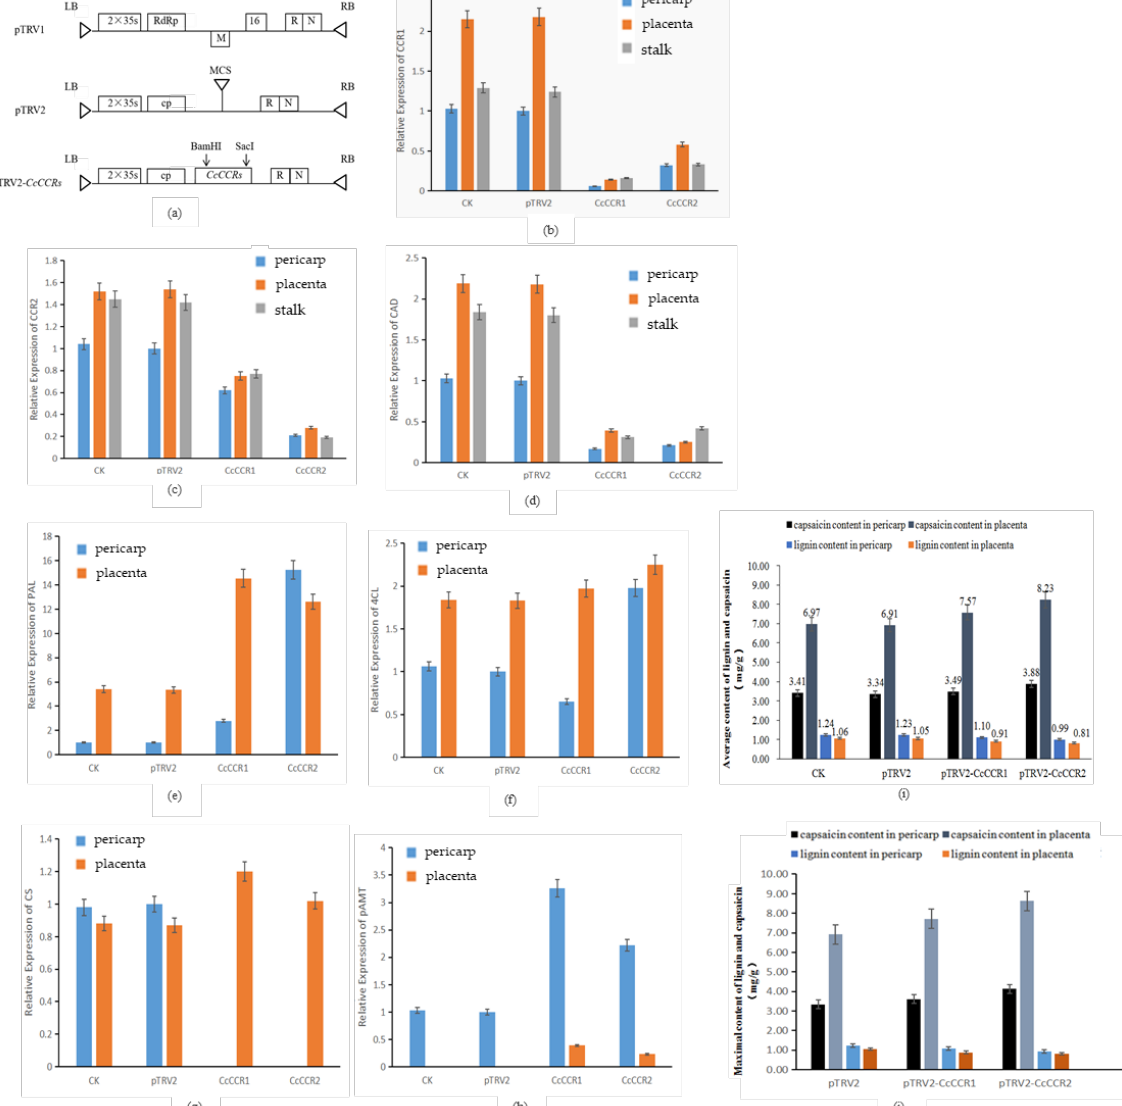
Figure 10. Determination of candidate gene expression and capsaicin and lignin content after inocu- lation. Note: ( a ) Vector construction, CCR gene insertion site. ( b – h ) The expression level of different genes under different treatments. ( i , j ) Contents of capsaicin and lignin in placenta and pericarp under different treatments. CK: blank control; pTRV2: pTRV2 no-load plant; CcCCR1/CcCCR2: silenced gene